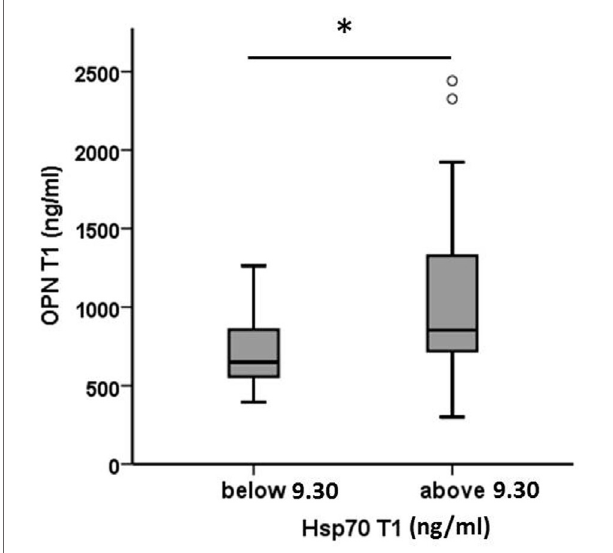
FigUre 1 | Comparison of pre-therapeutic (T1) osteopontin (OPN) levels in non-small-cell lung cancer patients (M0) with high and low median heat shock protein 70 (Hsp70) plasma levels. According to the median Hsp70 plasma level of 9.30 ng/ml the patient cohort ( n = 43) was divided into two